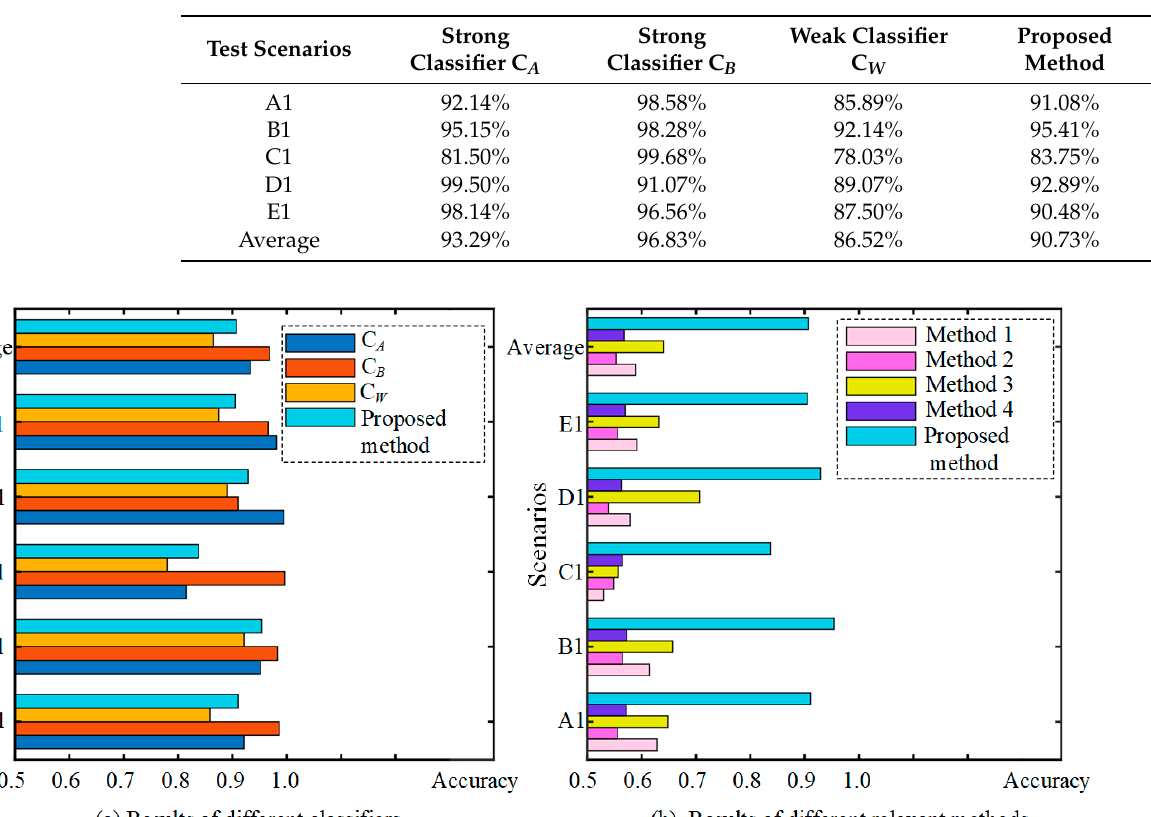
Table 6. Results of different classifiers.